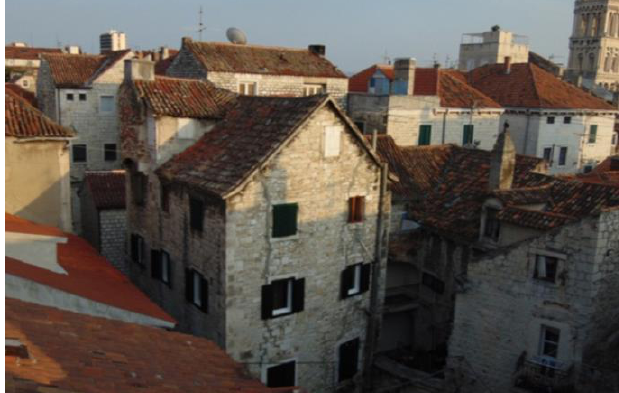
Figure 1. Diocletian Palace, listed on the UNESCO list,